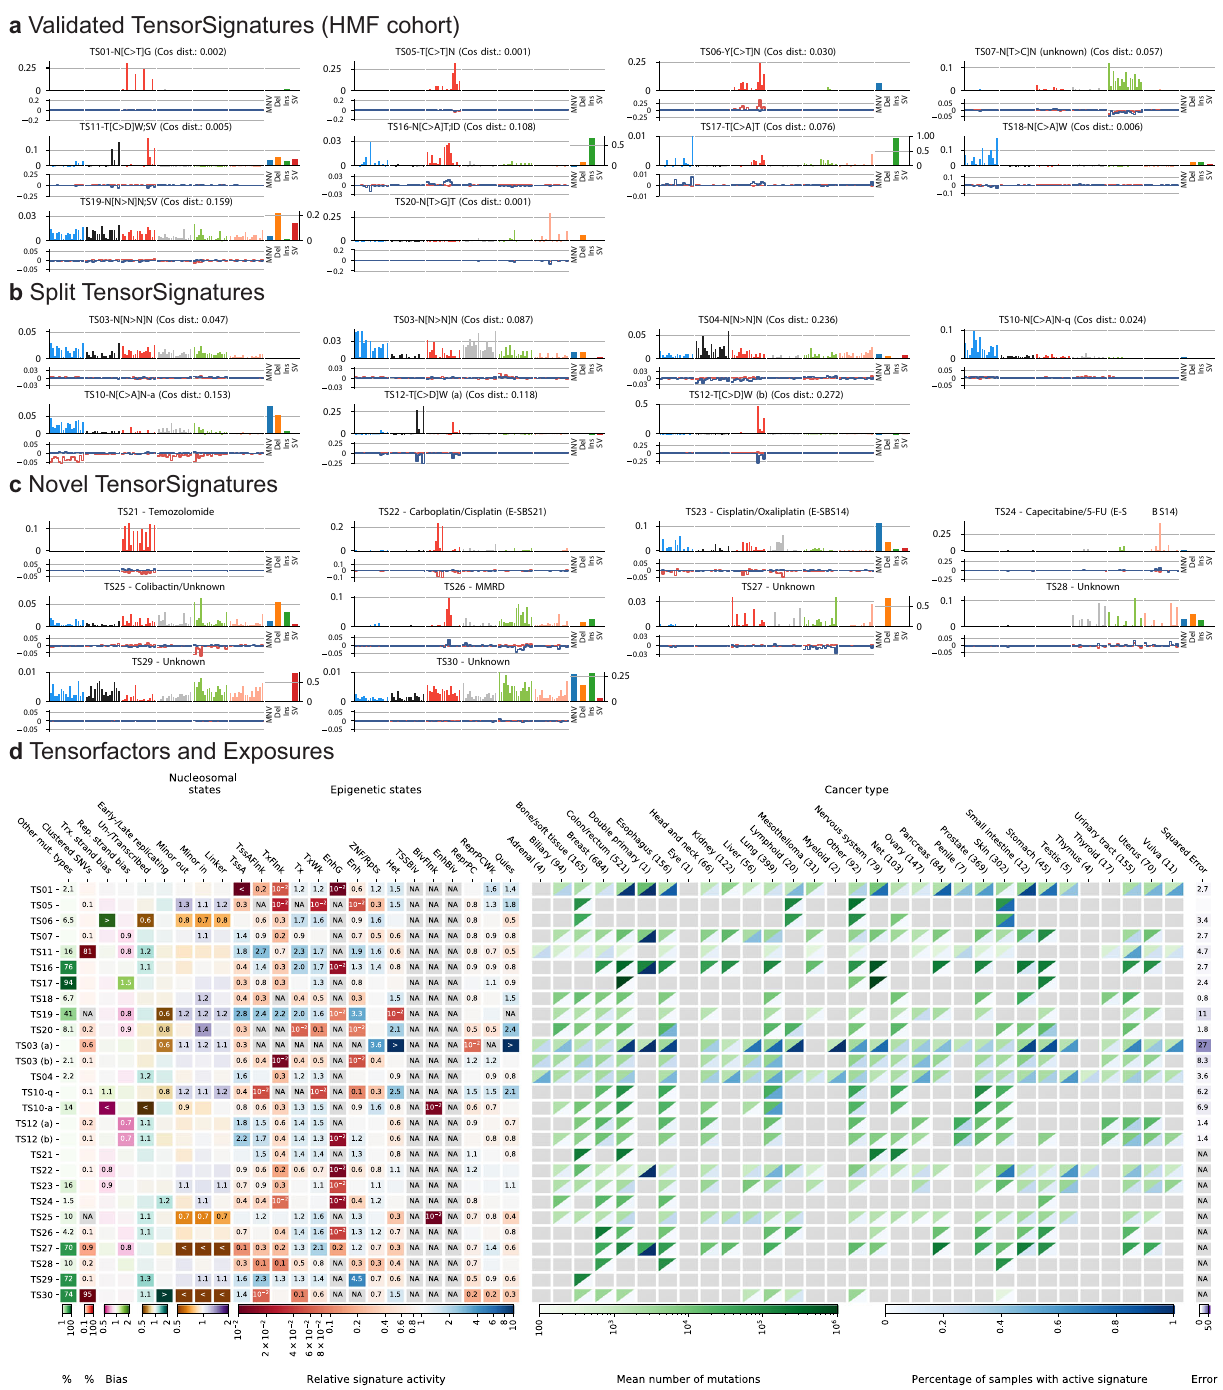
Fig. 3 Tensor signatures of the HMF cohort. a Validated tensor signatures with high similarity (indicated as cosine distance) to the mutational processes extracted in our discovery analysis using PCAWG data. b TensorSignatures splits that seemingly represent derivatives of tensor signature TS03, TS04, TS10 and TS12. c Tensor signatures of the HMF cohort. d Extracted tensor factors, exposures and summed squared errors of tensor factors from the discovery and validation analysis. Source data are provided as a Source Data fi